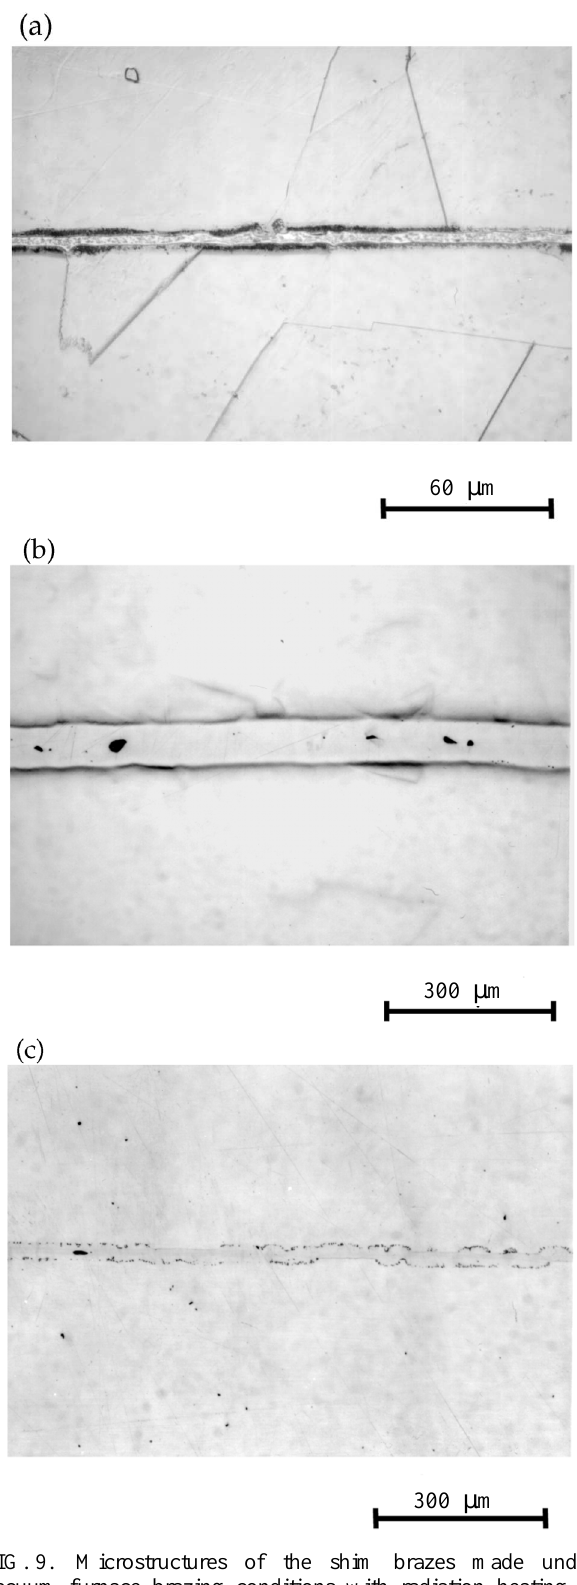
FIG. 9. Microstructures of the shim brazes made under vacuum furnace brazing conditions with radiation heating at 75 ± C (cid:1) min: (a) pure silver braze showing good wetting and minimal porosity, (b) pure gold braze with centerline porosity, and (c) Nioro braze with centerline and edge porosity.